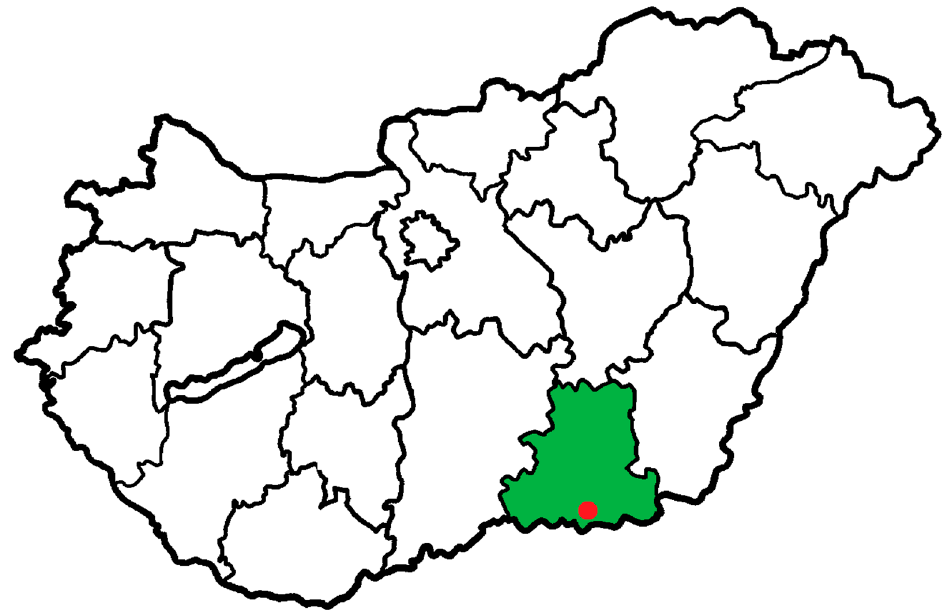
Figure 3. Study site in Hungary (Southern Great Plain of Hungary: in green; Albert Szent-Györgyi Clinical Center, Szeged: in red).